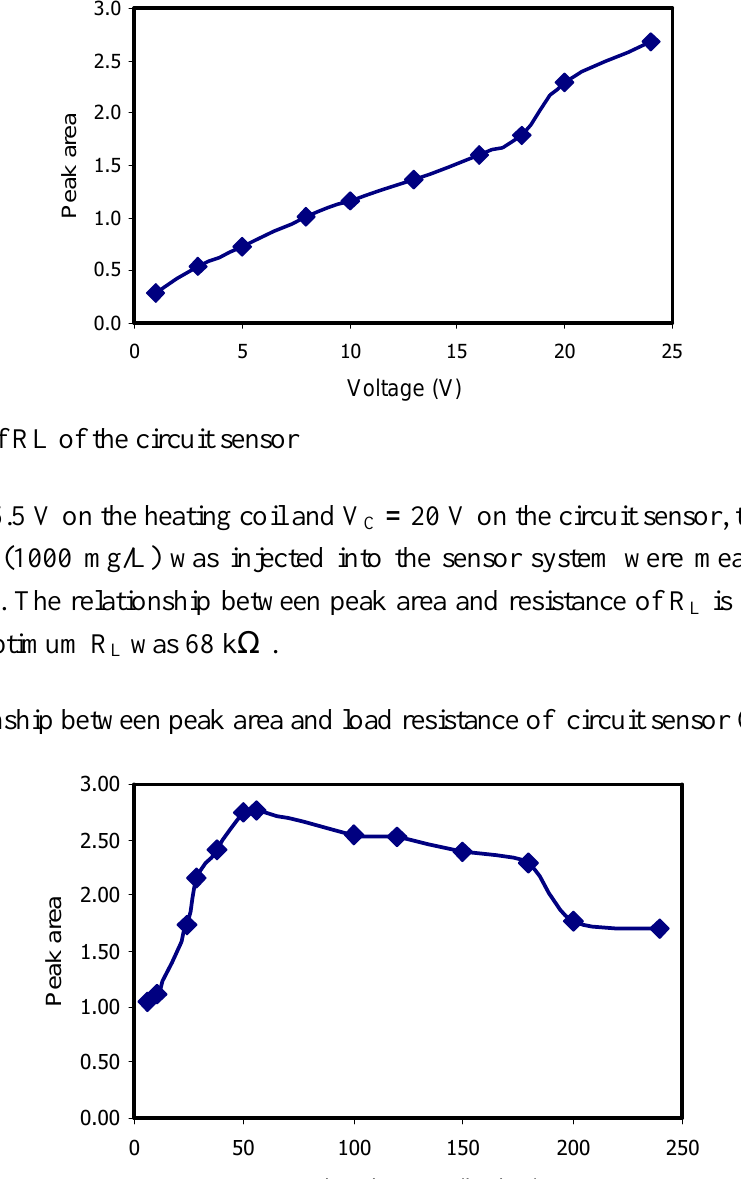
Figure 4. Relationship between peak area and voltage at circuit of V